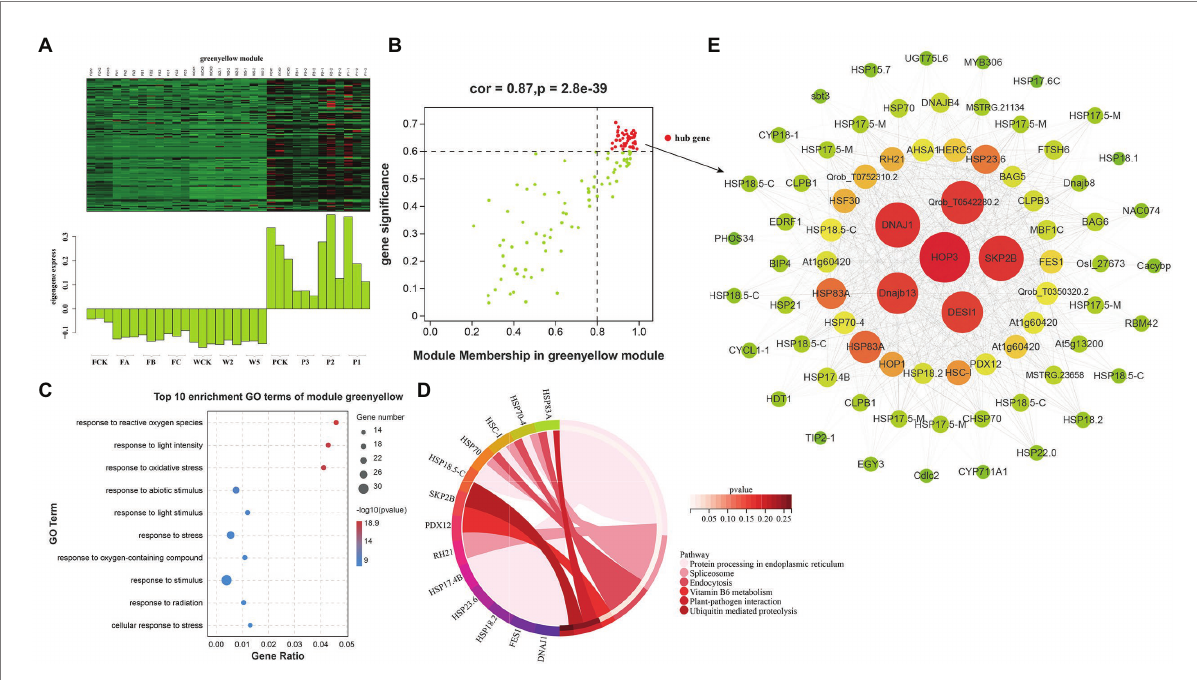
FIGURE 6 Coexpression network of the green-yellow module. (A) Gene coexpression heat map of the green-yellow module (upper panel) and expression of the corresponding eigengenes in each sample (lower panel). (B) MDA and the green-yellow module have a point map of the hub gene with higher connectivity and expression. The x axis represents the correlation between the expression of each gene and the module, and the y axis represents the correlation between each gene and the trait. (C,D) GO terms and KEGG enrichment analysis cycles of the top 10 hub genes associated with MDA traits in the green-yellow module. (E) Coexpression network of hub genes in the green-yellow module. The first 100 hub genes with a weight value >0.30 and higher expression were used to construct the